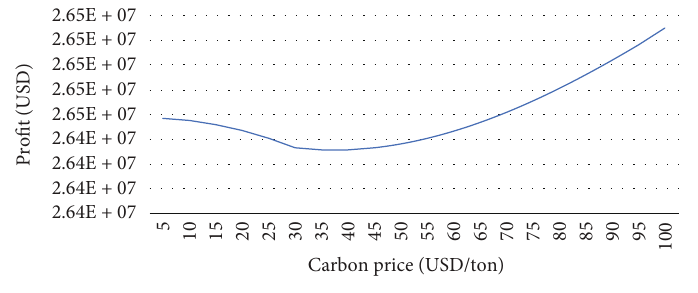
Figure 4: Pro fi t curve of carbon